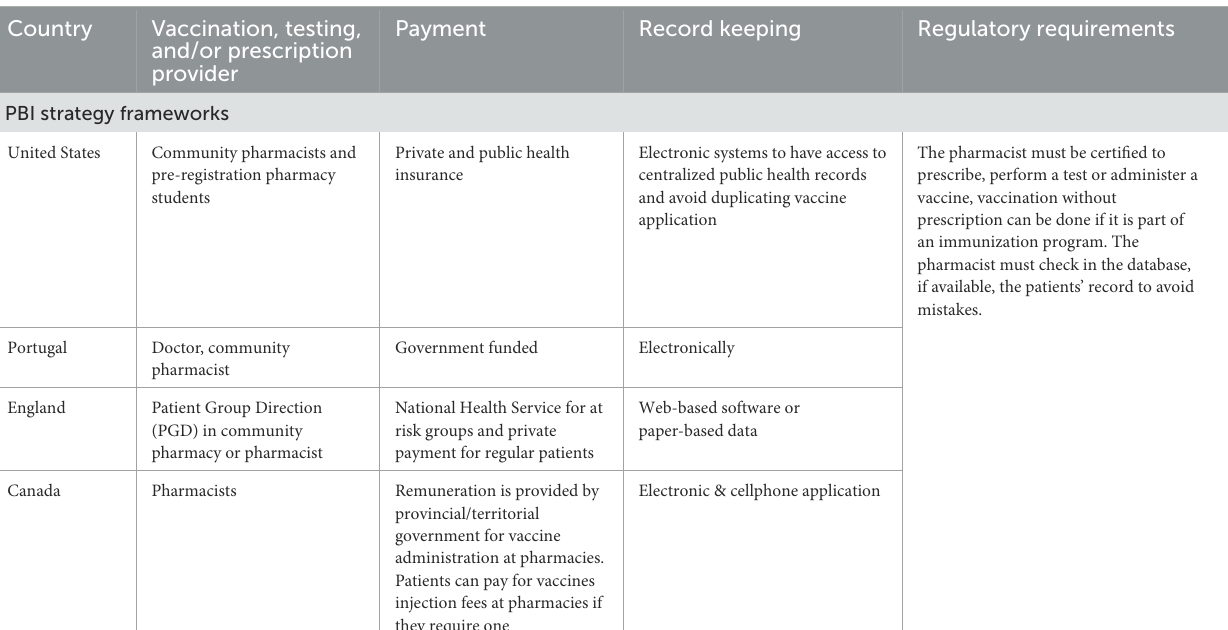
TABLE 1 PBI strategy